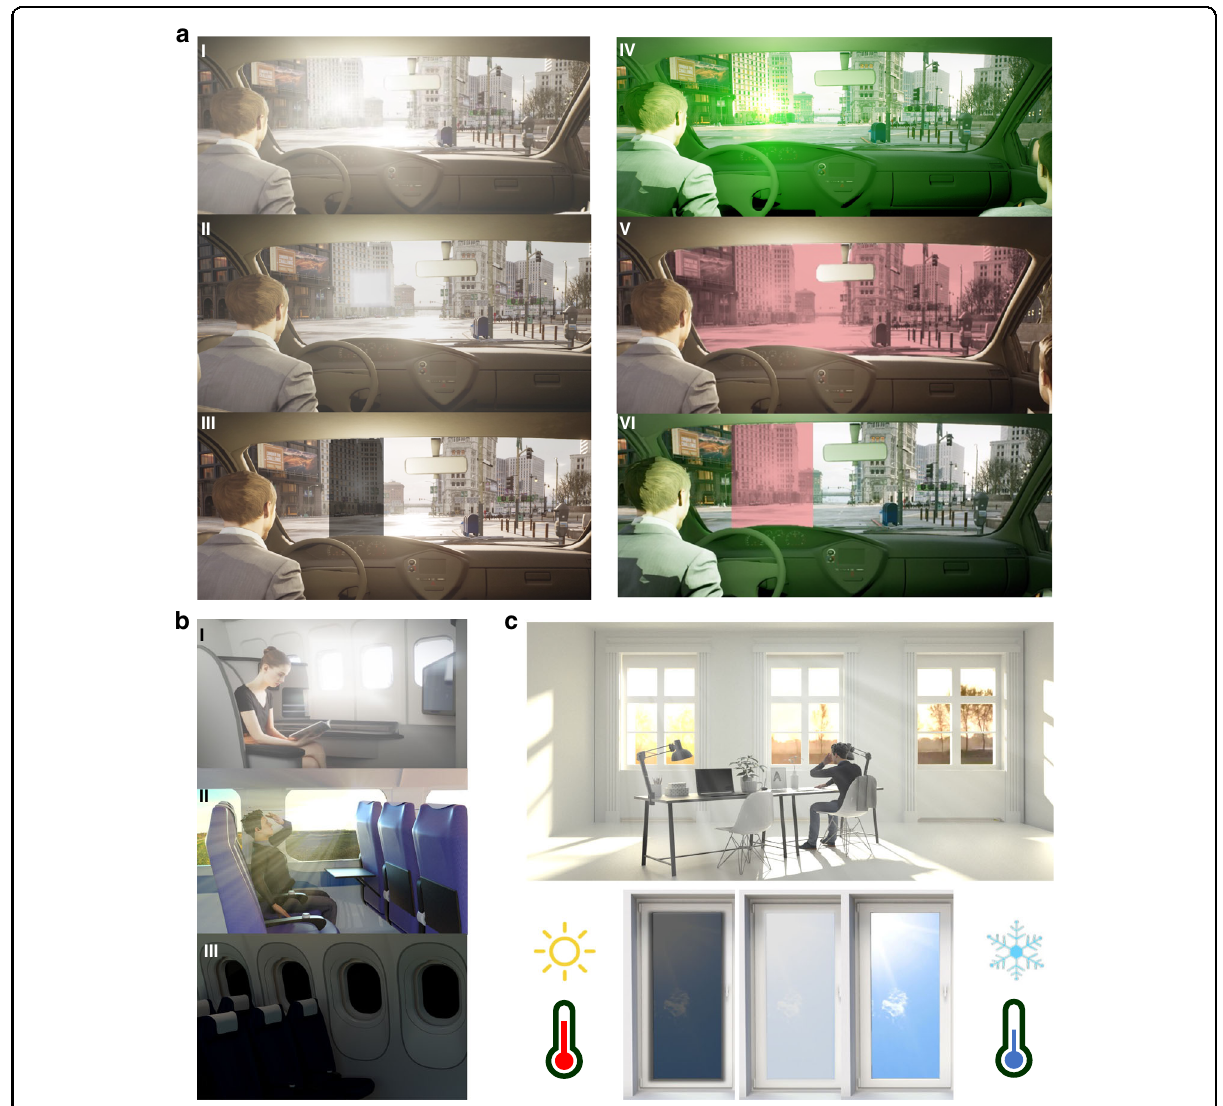
Fig. 12 Different light protection environment. a Windshields with rectifying protective members made of transparent material placed in front of the driver ’ s seat: (I – III) Effects of daylight and protection strategies; (IV – VI) Effects of arti fi cial light on windshields and protection strategies. b Other optical windows on vehicles and their light protection strategies. c Optical windows in buildings and their light protection